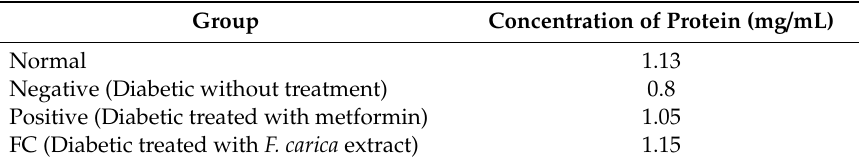
Table 1. Concentration of sperm protein (mg /